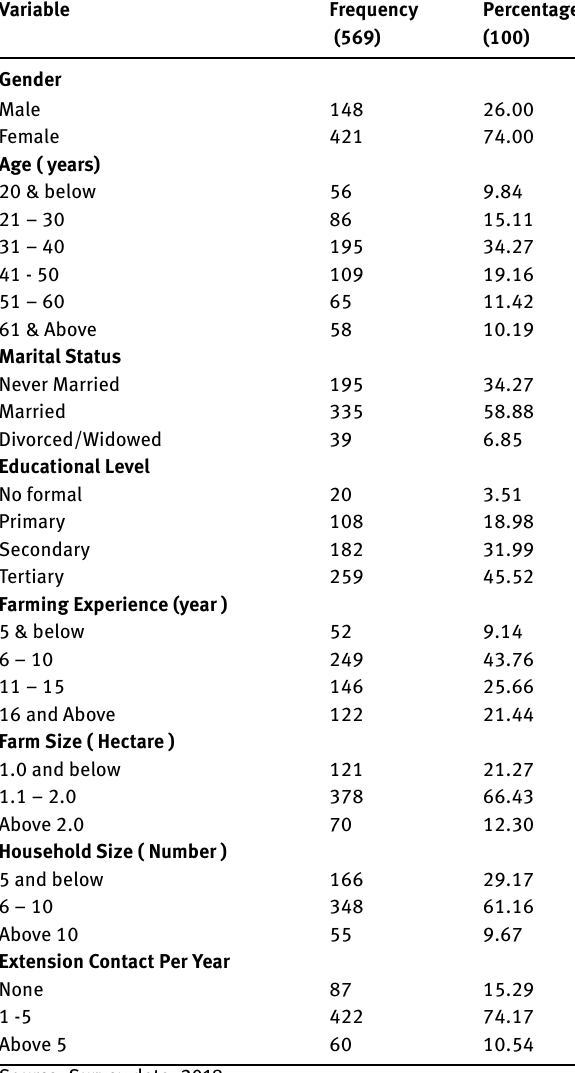
Table 2: Distribution of Socioeconomic characteristics of respon- dents (n =